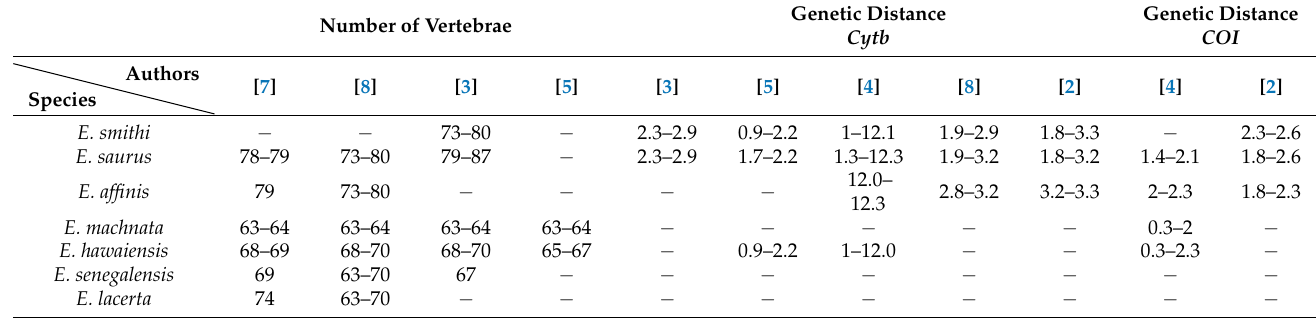
Table 1. Data used as diagnostic characters for Elops species, in studies by different authors.